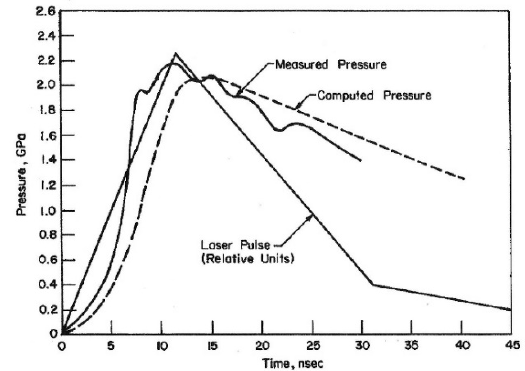
Figure 5. First modeling of pressure pulse for water overlay over a 3 µ m foil of aluminum against a quartz gauge